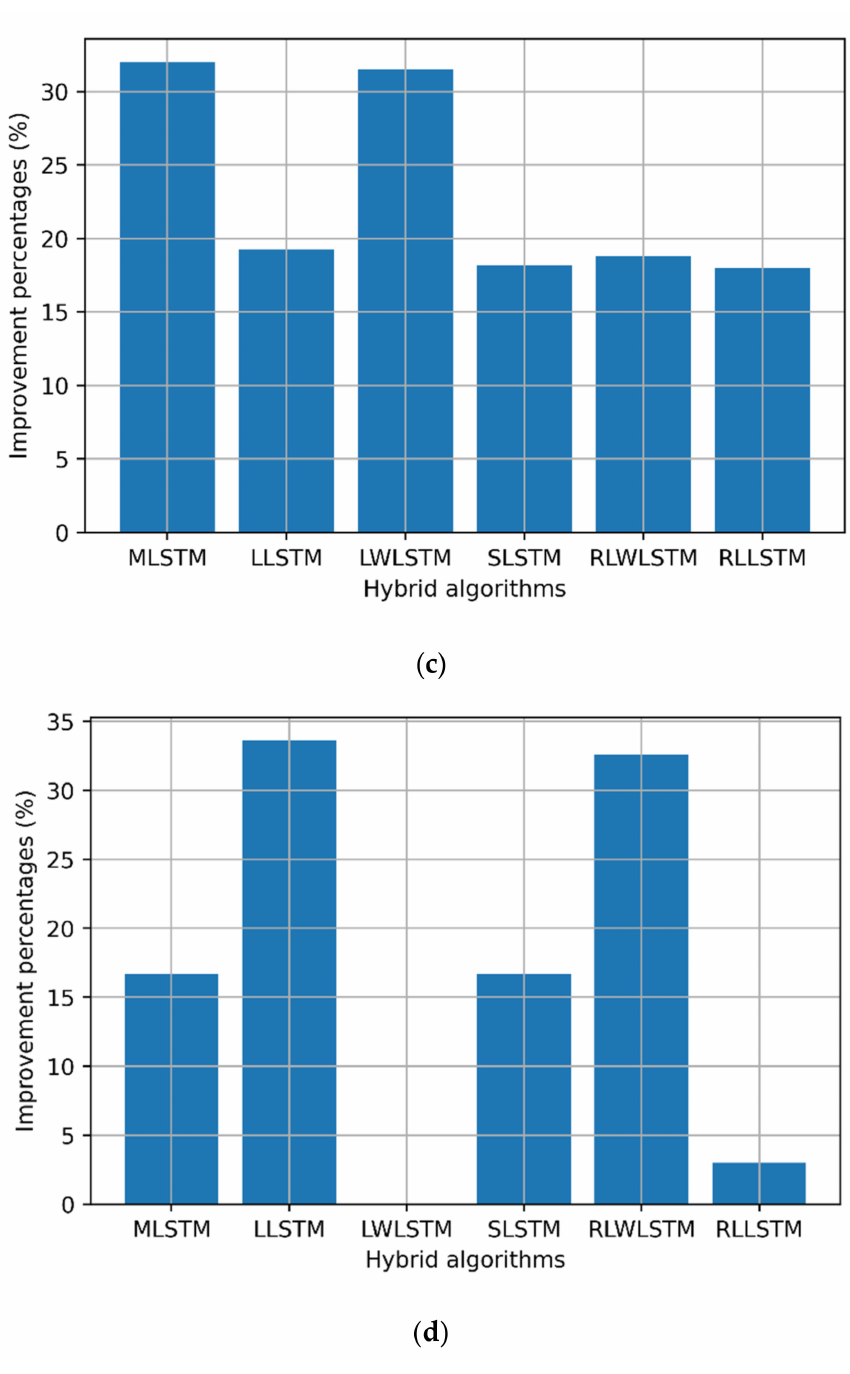
Figure 8. Improvement percentages for MPLS traffic: ( a ) training RMSE, ( b ) training time, ( c ) 350 time steps’ testing, and ( d ) 350 time steps’ testing